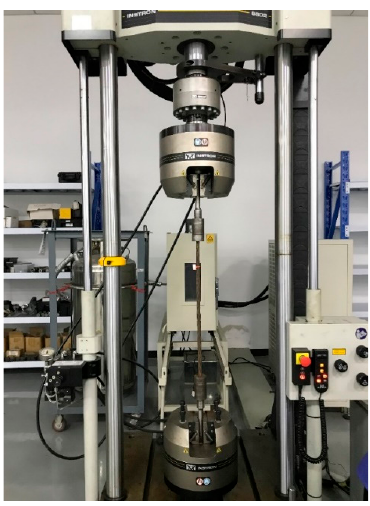
Figure 6. Fatigue test equipment for rusted steel strand.